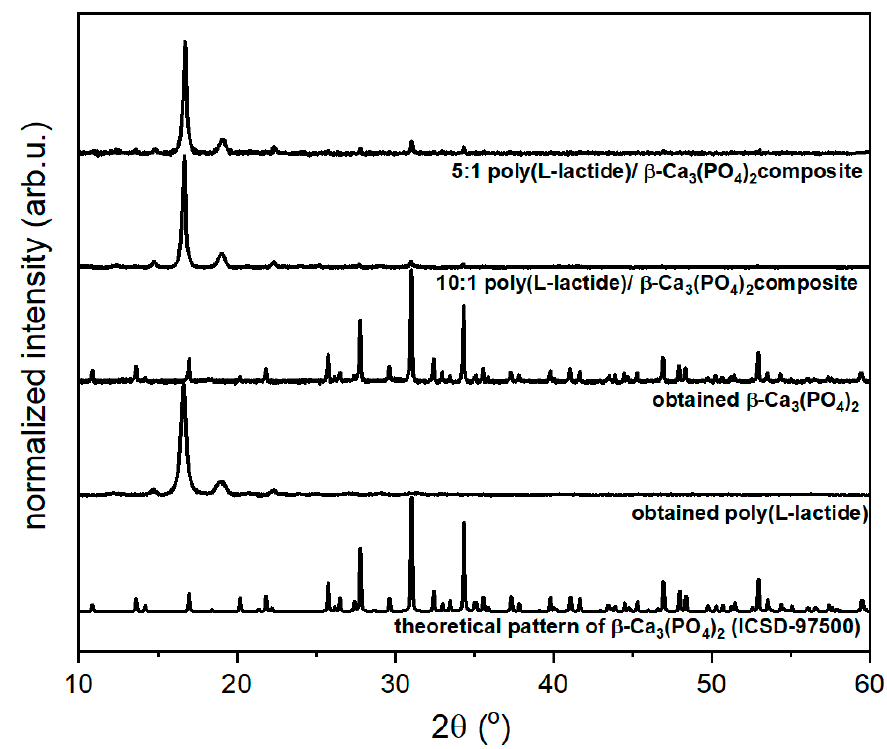
Figure 1. X-ray diffraction patters of poly( L -lactide) (PLLA), β -Ca 3 (PO 4 ) 2 ( β -TCP) co-doped with Ce 3+ and Pr 3+ ions and PLLA with β -Ca 3 (PO 4 ) 2 composite compared to theoretical pattern of β -Ca 3 (PO 4 ) 2 (ICSD-97500).